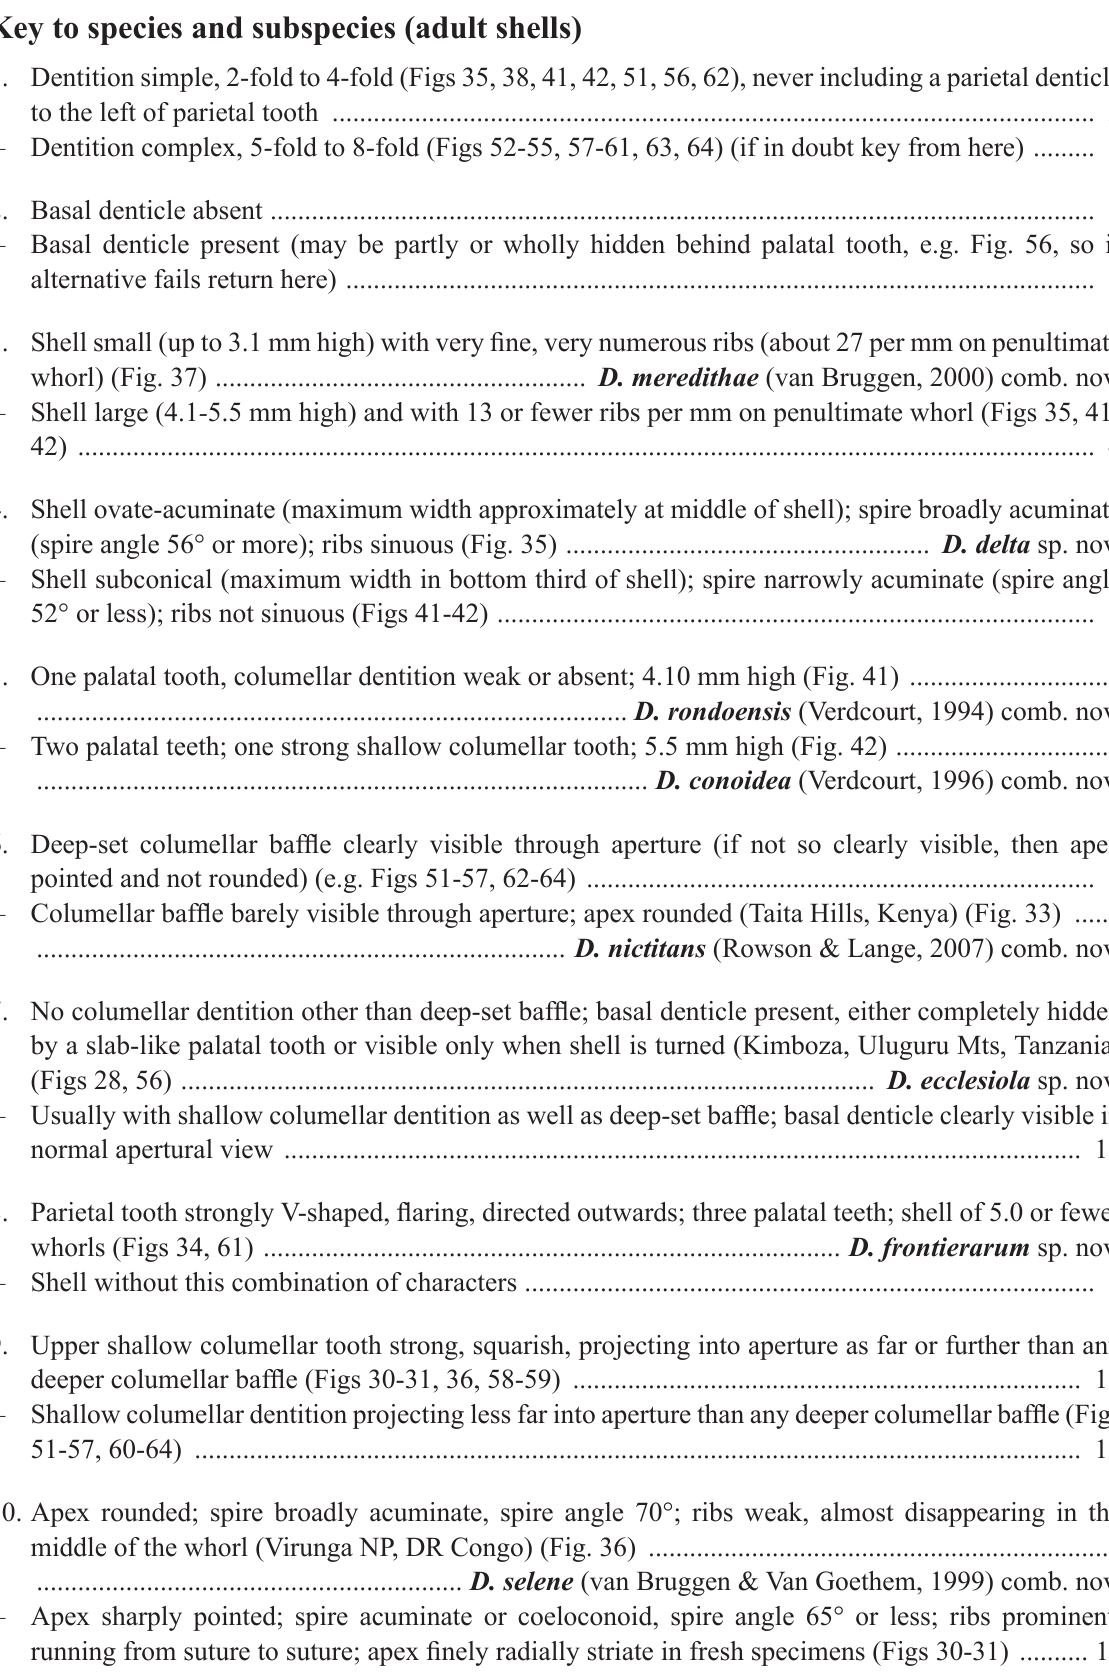
ROWSON B. & TATTERSFIELD P., Revision of Dadagulella gen. nov.